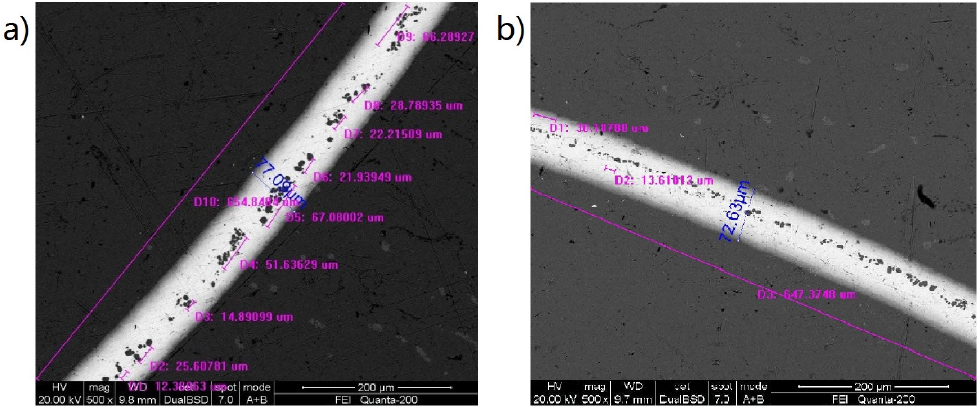
Figure 16. Cross-sectional SEM morphologies ( a , b ) of the brazed interfacial microstructure for the sample brazed with side solder feeding.